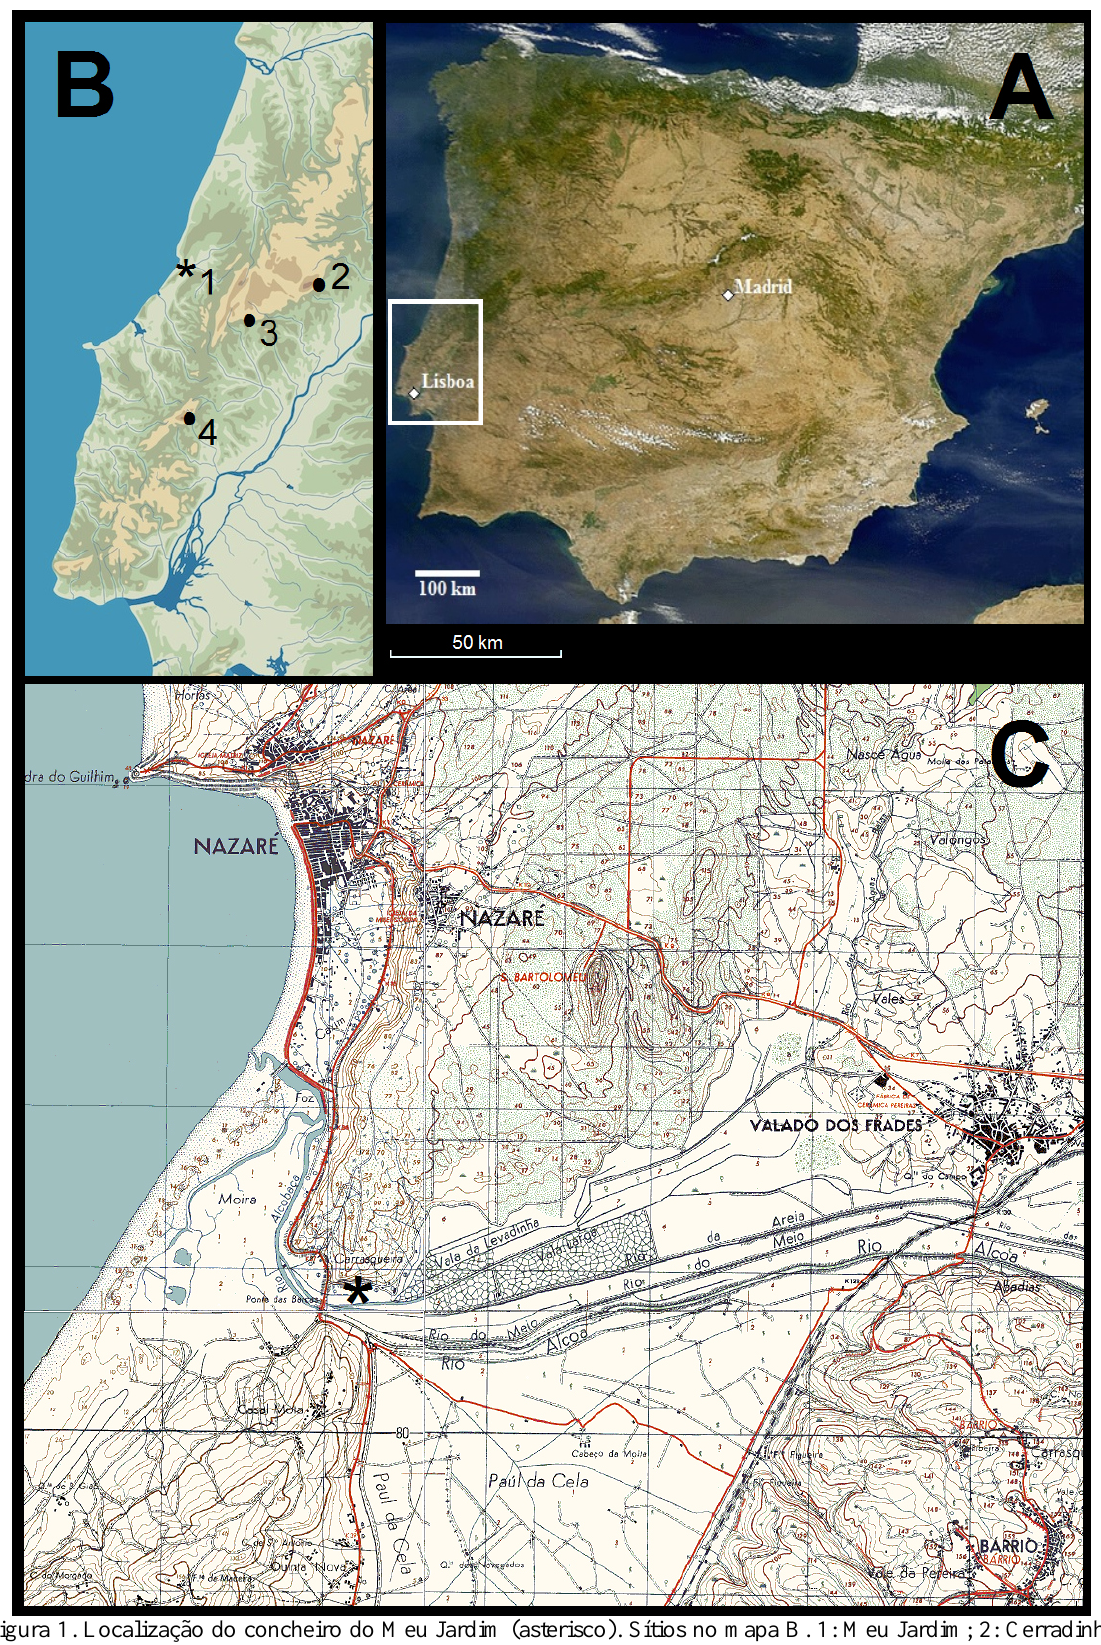
Figura 1. Localização do concheiro do Meu Jardim (asterisco). Sítios no mapa B. 1: Meu Jardim; 2: Cerradinho do Ginete (Torres Novas); 3: Gruta do Lugar do Canto (Alcanena); 4: Algar do Bom Santo (Alenquer). Figure1. Location of the Meu Jardim shell-midden (asterisk). Sites in map B. 1: Meu Jardim; 2: Cerradinho do Ginete (Torres Novas); 3: Gruta do Lugar do Canto (Alcanena); 4: Algar do Bom Santo Journal of Lithic Studies (2017) vol. 4, nr. 3, p. 79-102 doi:10.2218/jls.v4i3.2533